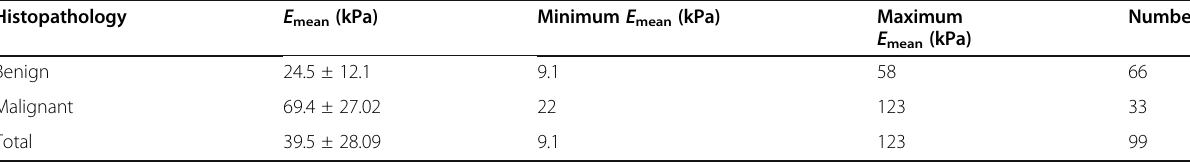
Table 3 Showing correlation between SWE and the pathological results of the nodules Histopathology E mean